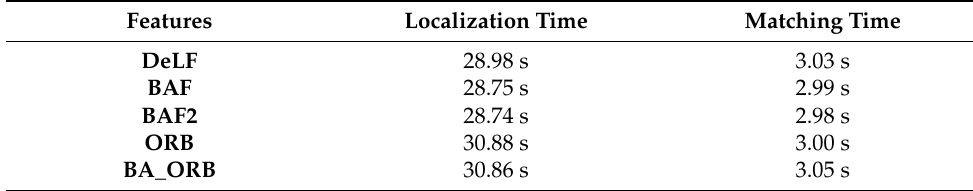
Table 7. Time cost of different features.